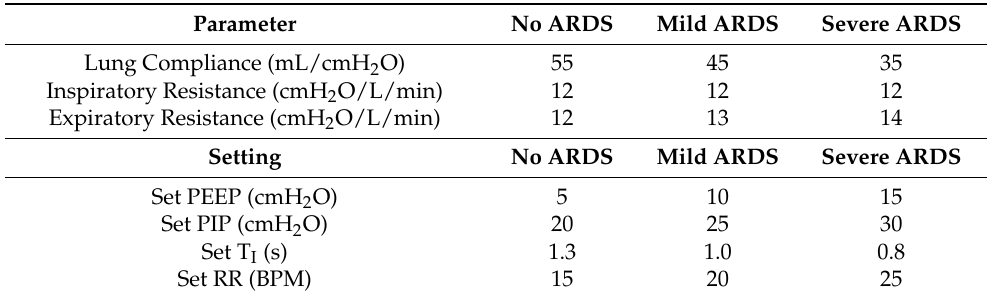
ARDS = acute respiratory distress syndrome; PEEP = positive end expiratory pressure; PIP = peak inspiratory pressure; T I = inspiratory time; RR = respiratory